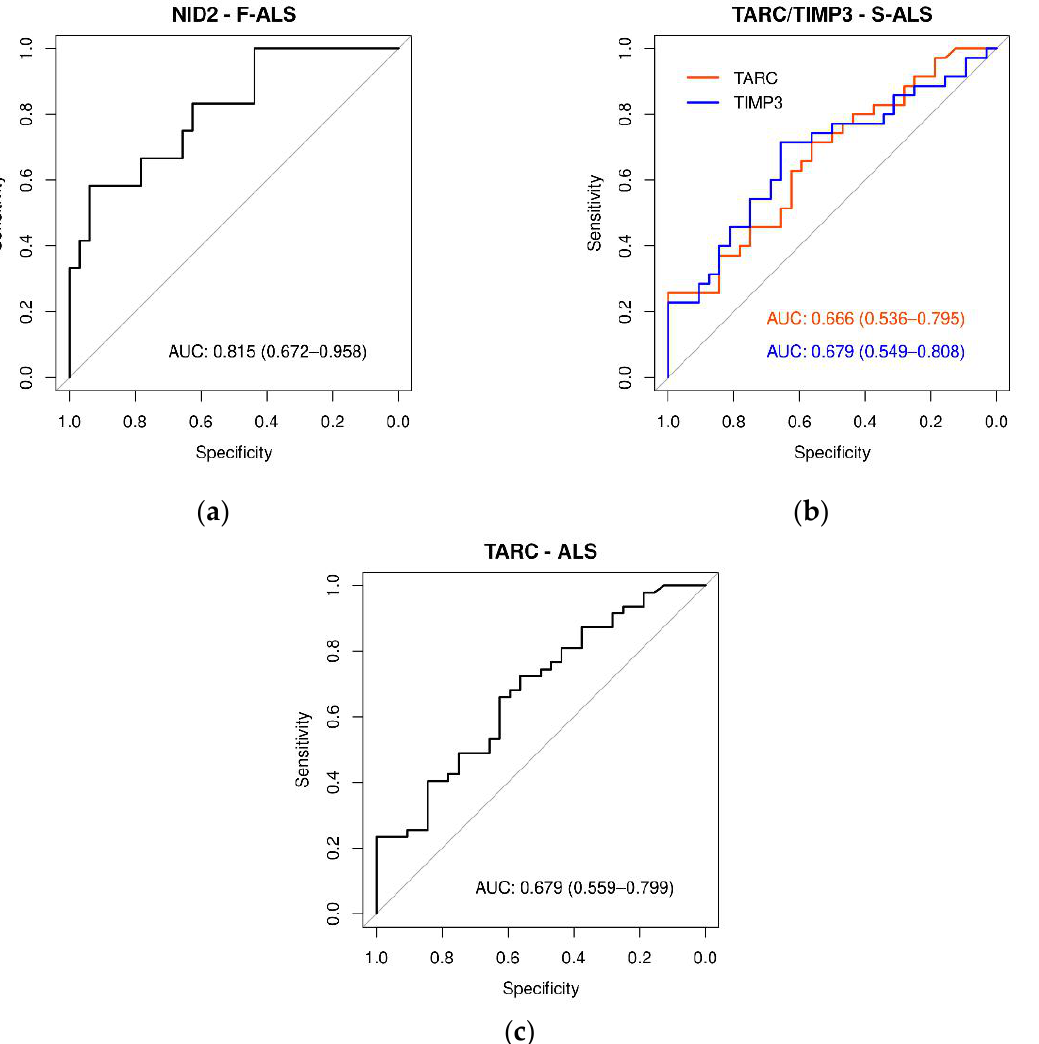
Figure 7. ROC curves of plasma protein levels in ALS, F-ALS and S-ALS referring to TARC, TIMP-3, NID1 and NID2 expression levels. The AUC indicates the diagnostic power: ( a ) NID2 in F-ALS patients (0.815), ( b ) TARC and TIMP3 in S-ALS patients (0.67) and ( c ) TARC in-ALS patients (0.68).